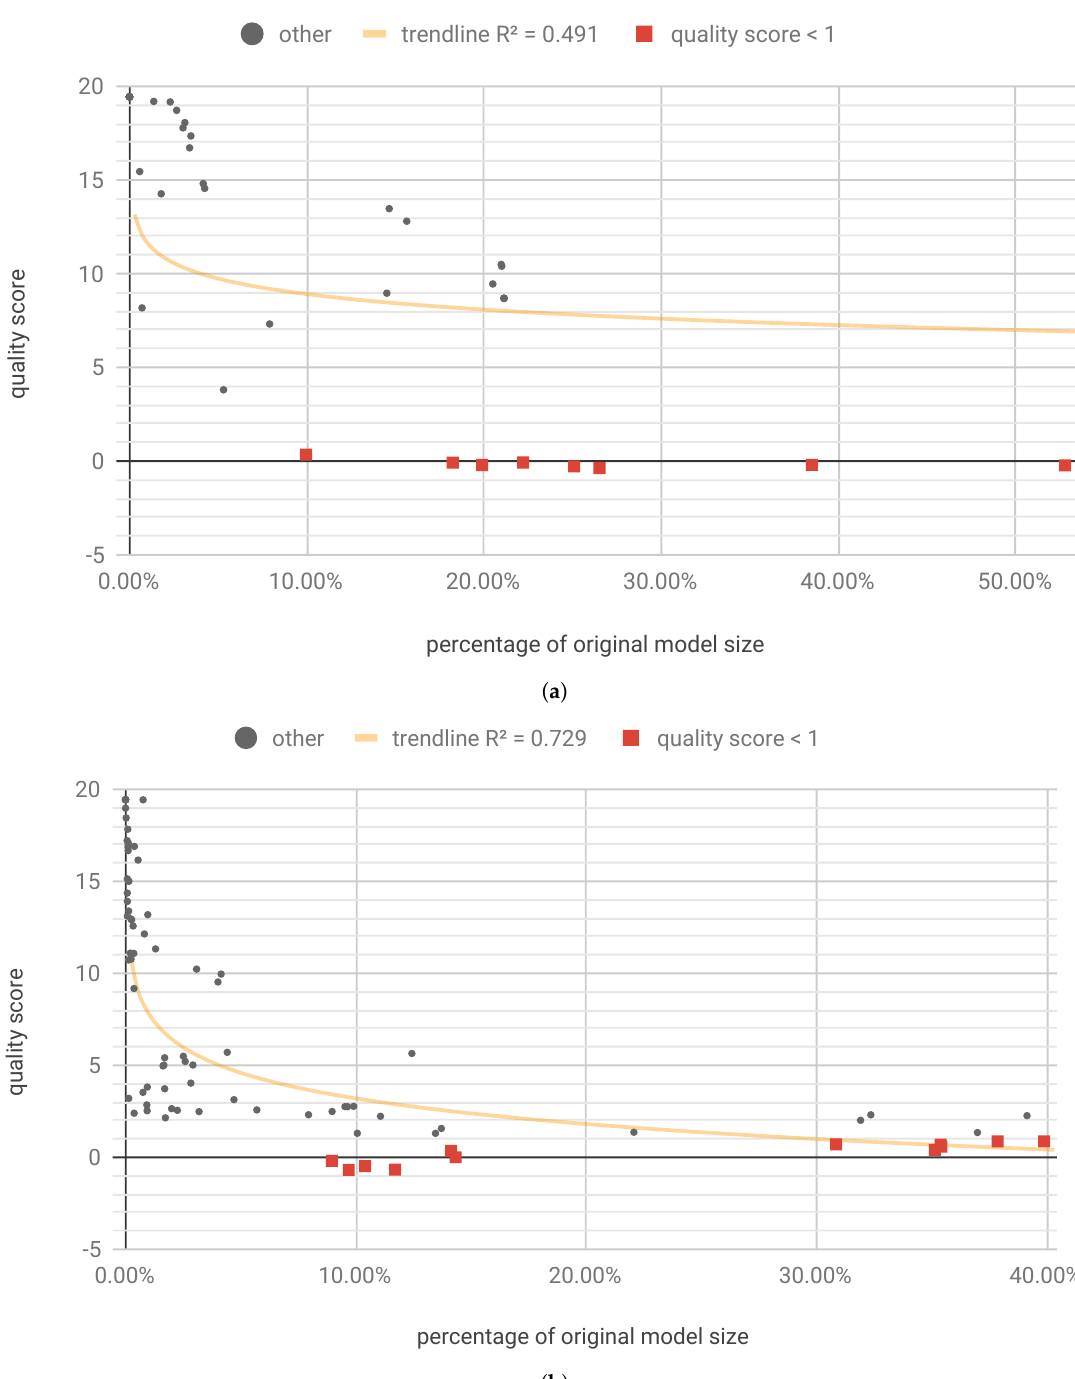
Figure 13. [LHC] Unique first Pareto front results for model trained on bucketized data. ( a ) Flow D-A: per-model pruning and quantization. trendline ( x ) = 6.16 − 1.19ln x ; ( b ) Flow D-B: individualized pruning and quantization. trendline ( x ) = − 1.42 − 2.01ln x